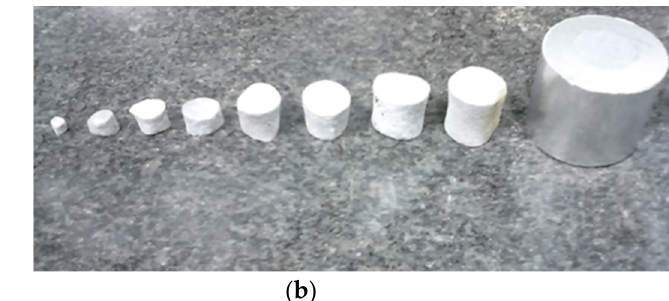
Figure 5. ( a ) Comparison between the residue of a totally solid specimen and that of pressed powder after approximately 2 h in a 6 M solution at 60°C (0.015 mm/min surface [24]). ( b ) Evolution of a pressed-powder specimen fully submerged in a 6 M solution at